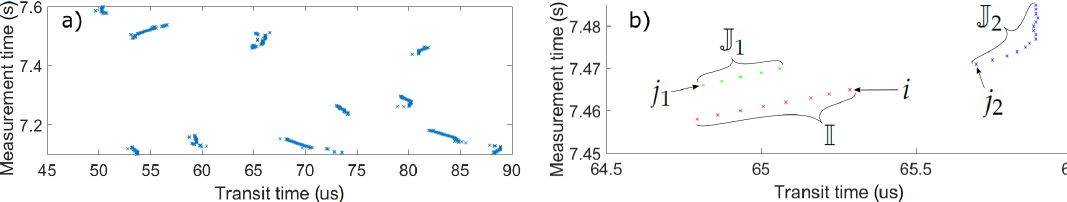
Figure 2. ( a ) Example of points for tracking. ( b ) The last point i of a trajectory I and the first point j 1 of a later trajectory J 1 were used to calculate the distance function D ( I , J 1 ) . The same way was used for trajectory J 2